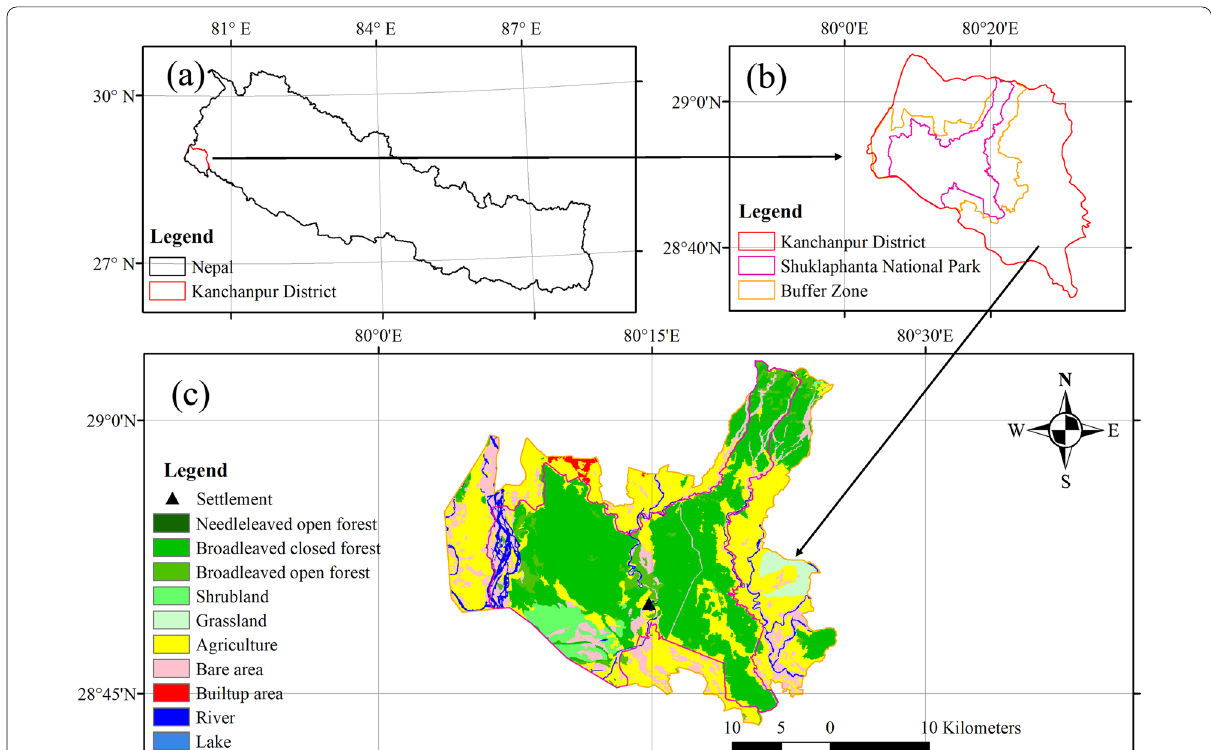
Fig. 1 Study area ( a ) map showing Kanchanpur district in Nepal, ( b ) Shuklaphanta National Park core area and buffer zone in Kanchanpur district, ( c ) different land use-land cover types inside the